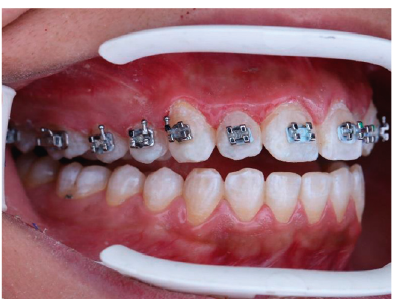
Figure 6: Postoperative view immediately after transfer tray removal.